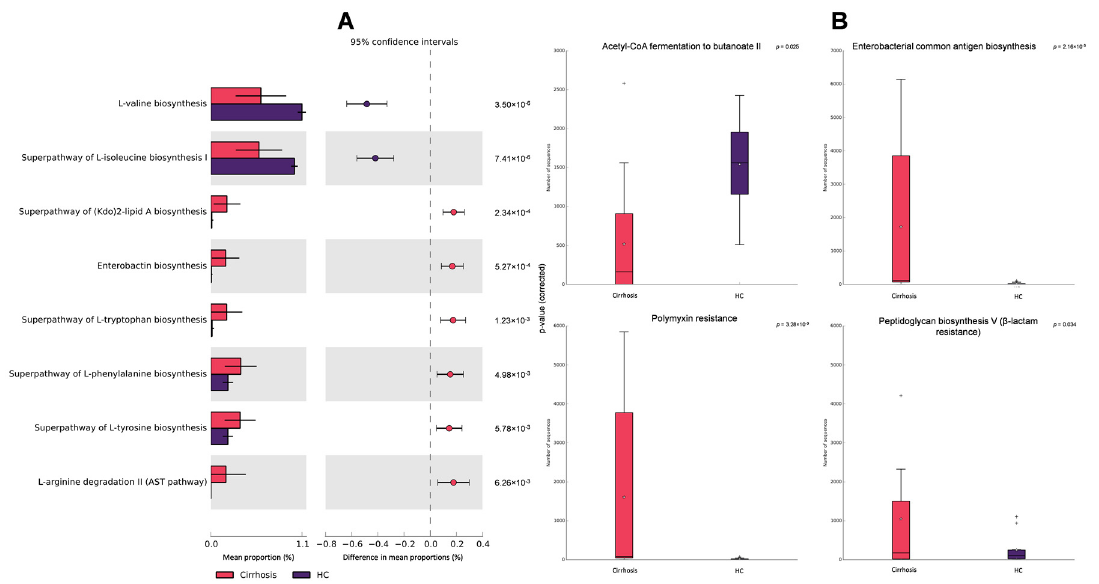
Figure 4. PICRUSt2 functional prediction of the patients with cirrhosis (red) compared with healthy controls (HC, purple). ( A ) Comparisons among MetaCyc pathways shown by mean proportion and difference in mean proportions; ( B ) Most relevant pathways are shown individually. The analysis was done with Welch’s inverted method, p -values were filtered with a cut-off value of p < 0.05.